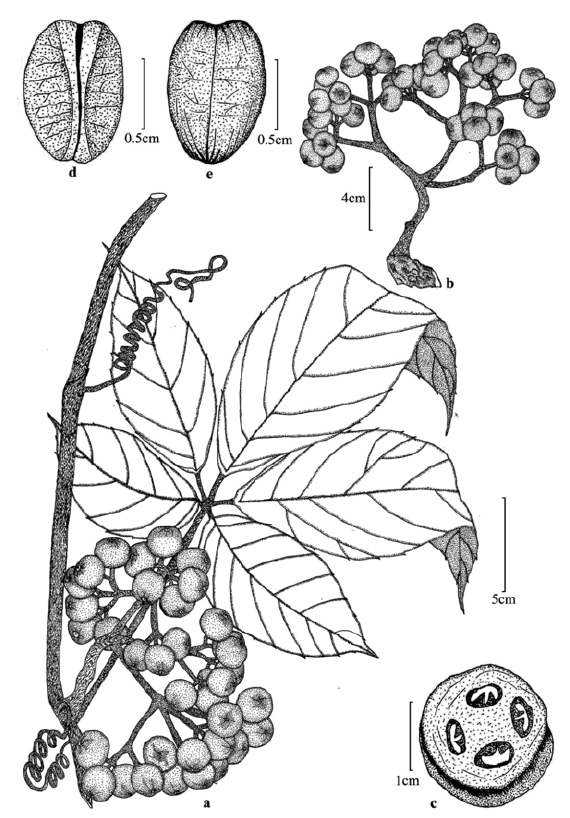
Figure 5. Tetrastigma obovatum (M.A. Lawson) Gagnep.: a—fruiting twig | b—fruit | c—tranverse section of fruit | d—seed (adaxial view) | e—seed (abaxial view).